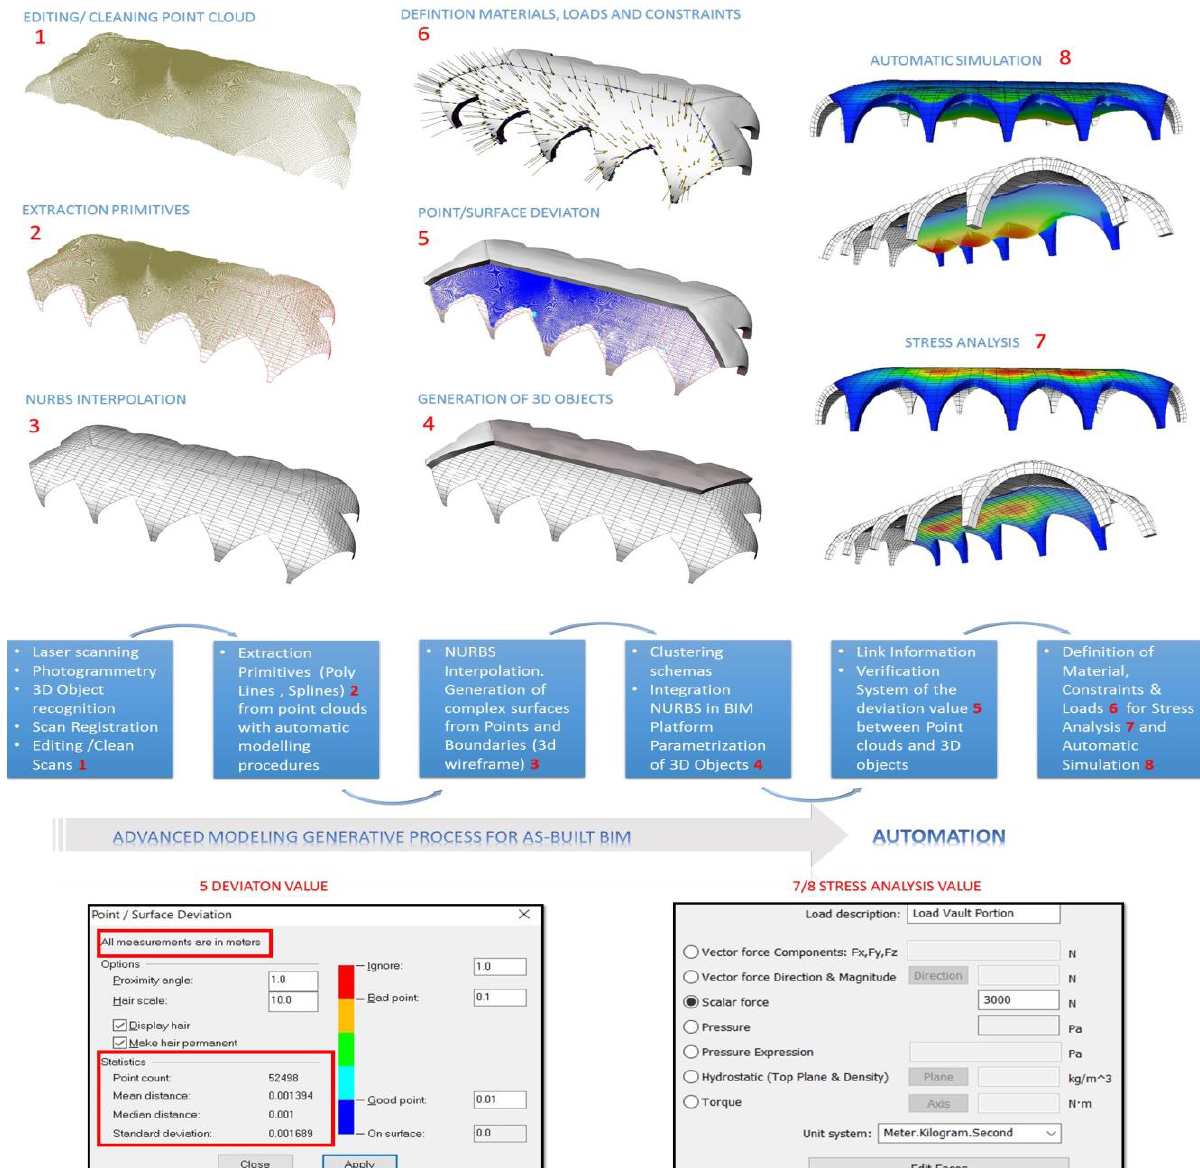
Fig. 7. Advanced Modeling Generative Process for as-built BIM. The method allows the creation of 3D objects of complex structural elements such as the main vault of Masegra Castle. The level of automation (LoA) permits to achieve a deviation value of 0,001689 m between 52489 points and complex element, enabling architects and engineers to achieve model numerical simulations by Finite Element Analysis